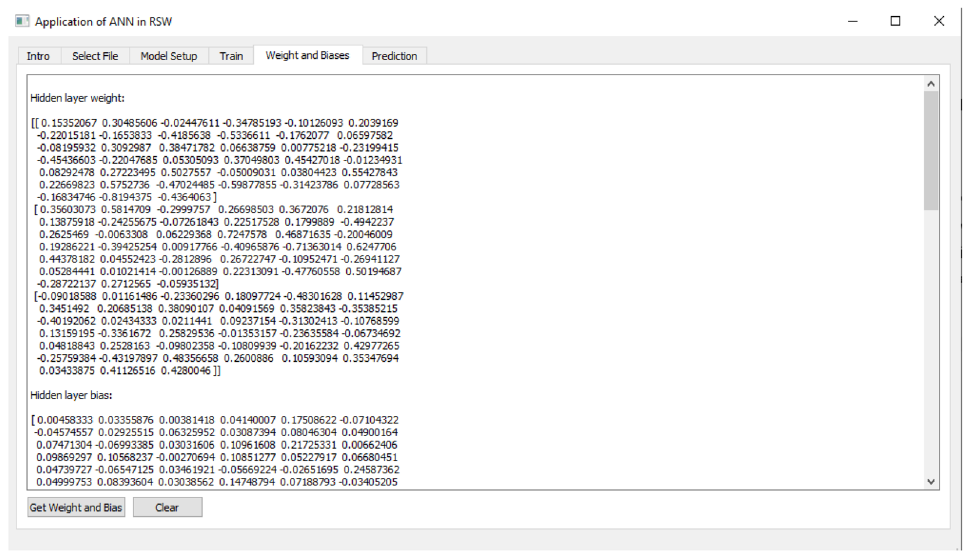
Figure 11. Display of current weights and biases of the ANN model as Tab